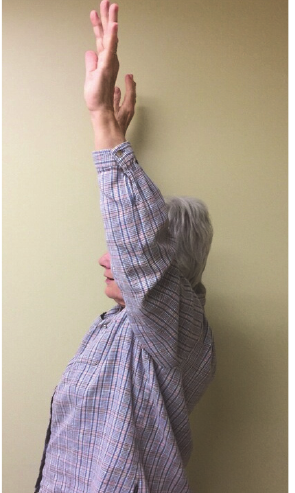
Figure 3: Patient exhibiting excellent range of motion at 6-month postop